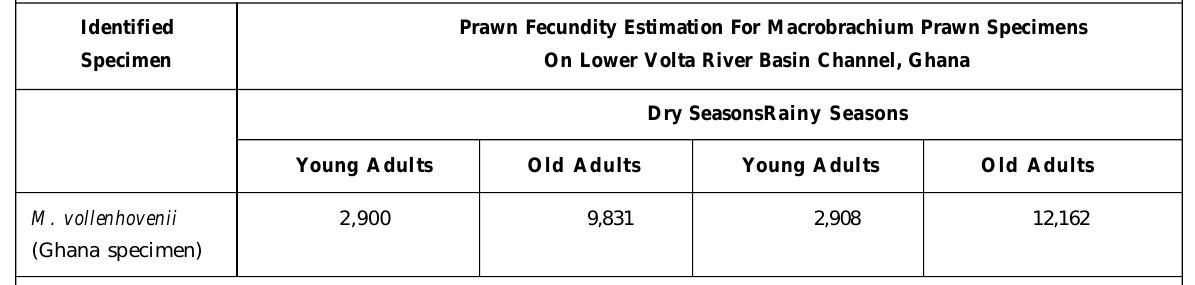
Table 7: Absolute fecundity estimation for M. vollenhovenii specimens collected from Studied Sections of Lower Volta River, Ghana based on their age class distribution and seasonality of sampling